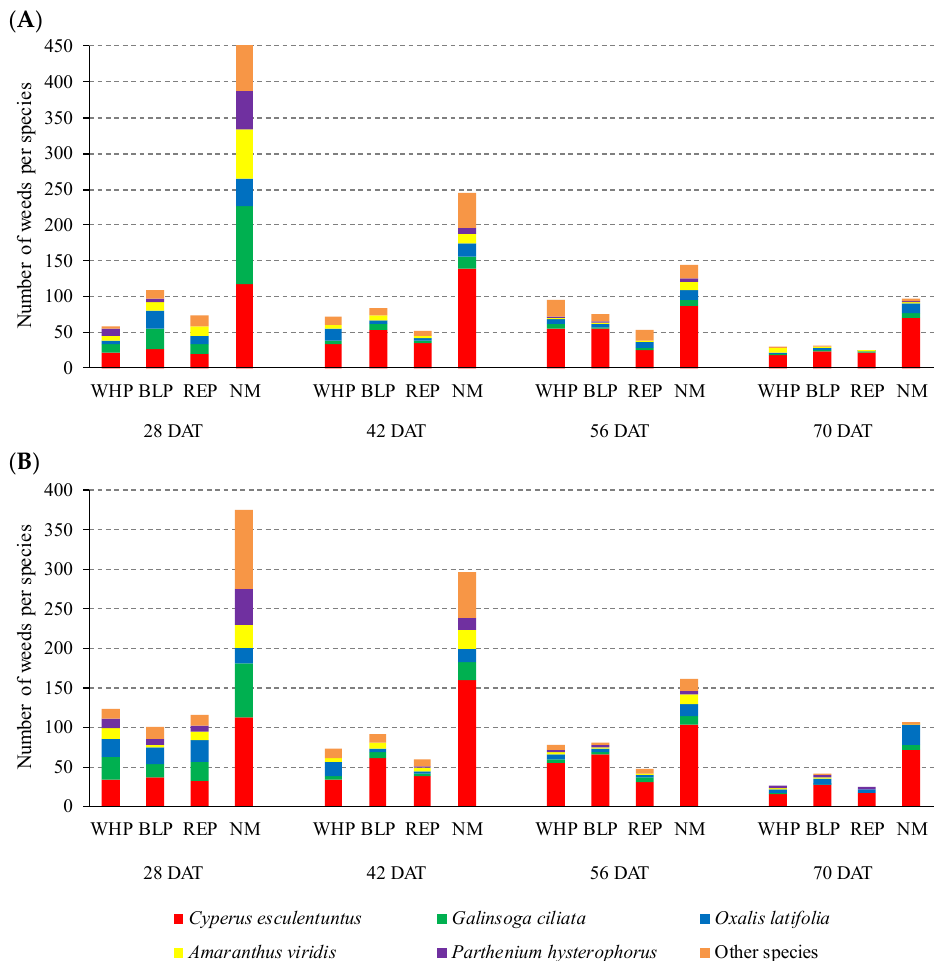
Figure 7. Occurrence of weed species collected at different times of the strawberry cycle that were cultivated with different mulching and wet areas of 40% ( A ) and 70% ( B ). WHP—White polyethylene,